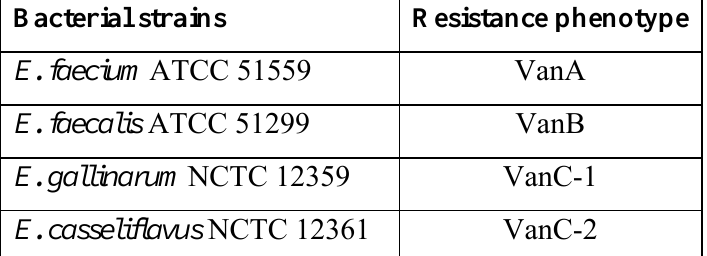
Table 6. Genus- and species-specific PCR primers and their product sizes and the